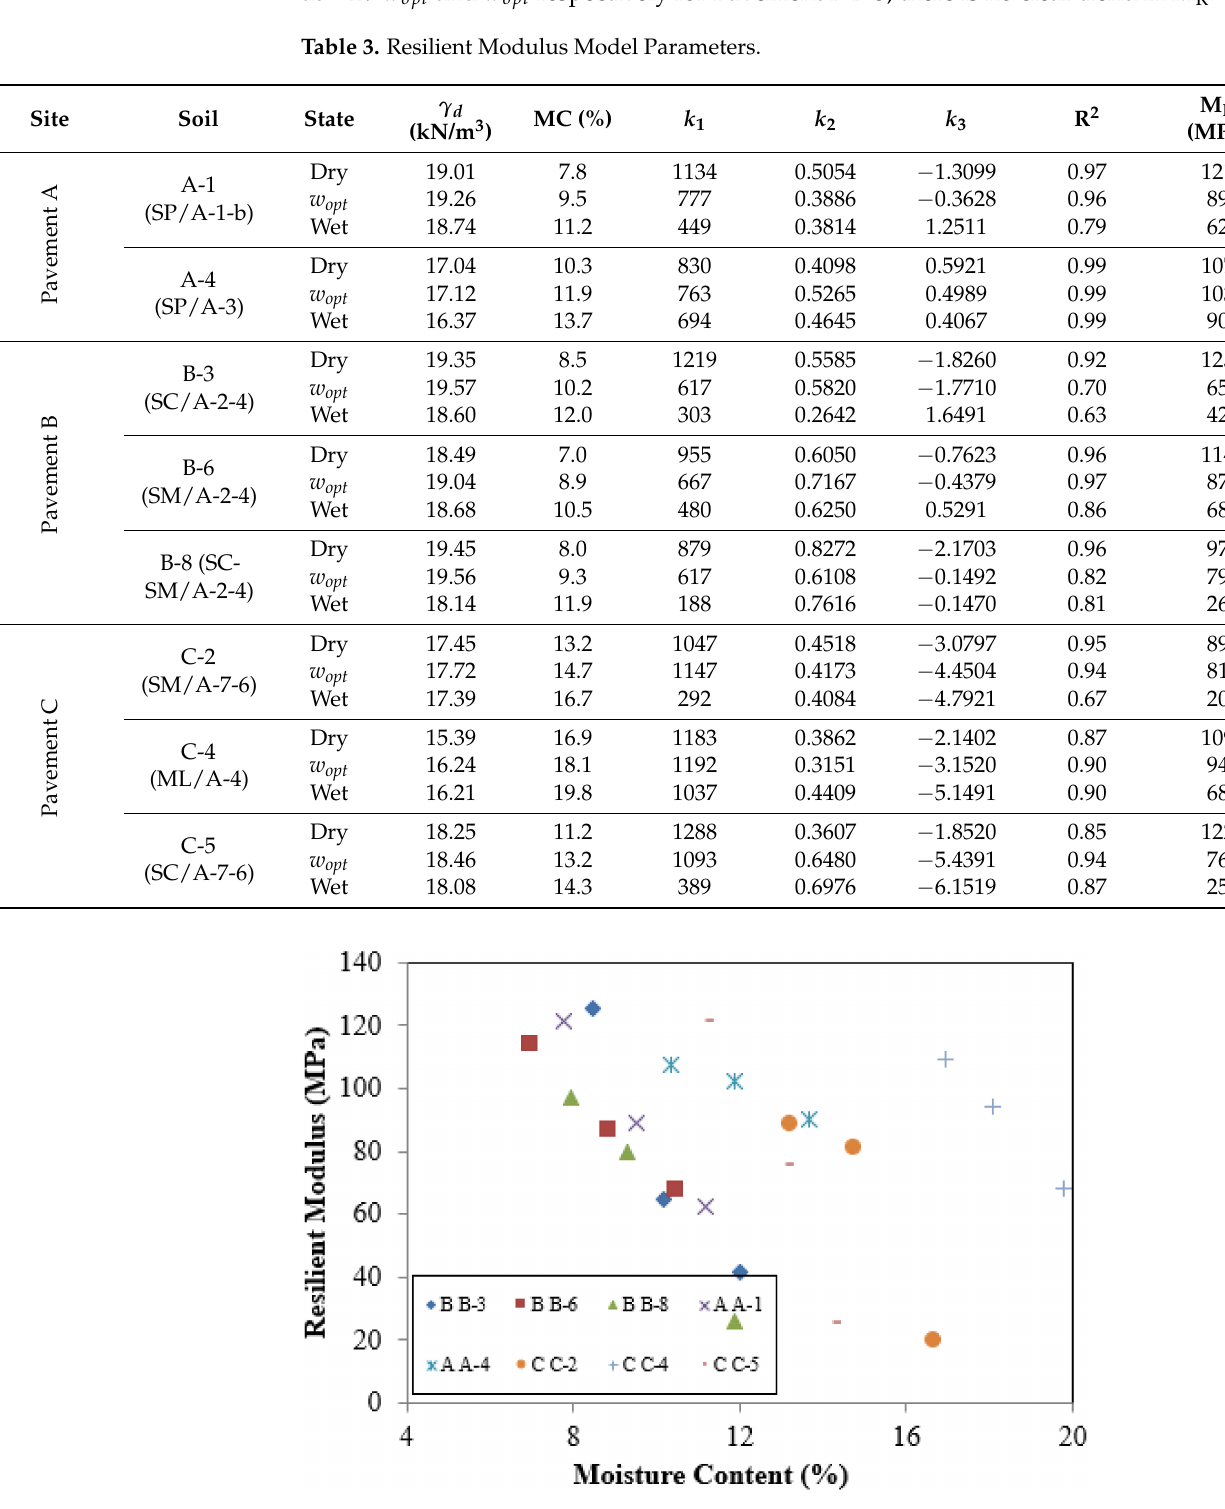
Figure 4. Effects of Moisture Content with Resilient